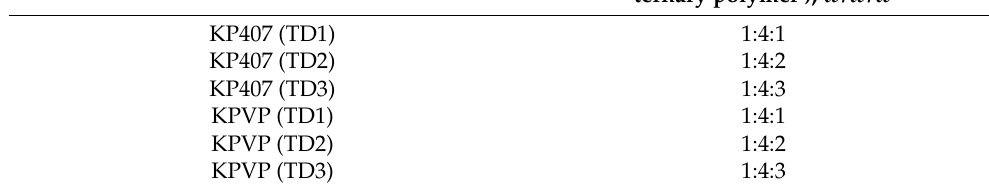
Formulation code (Ternary solid